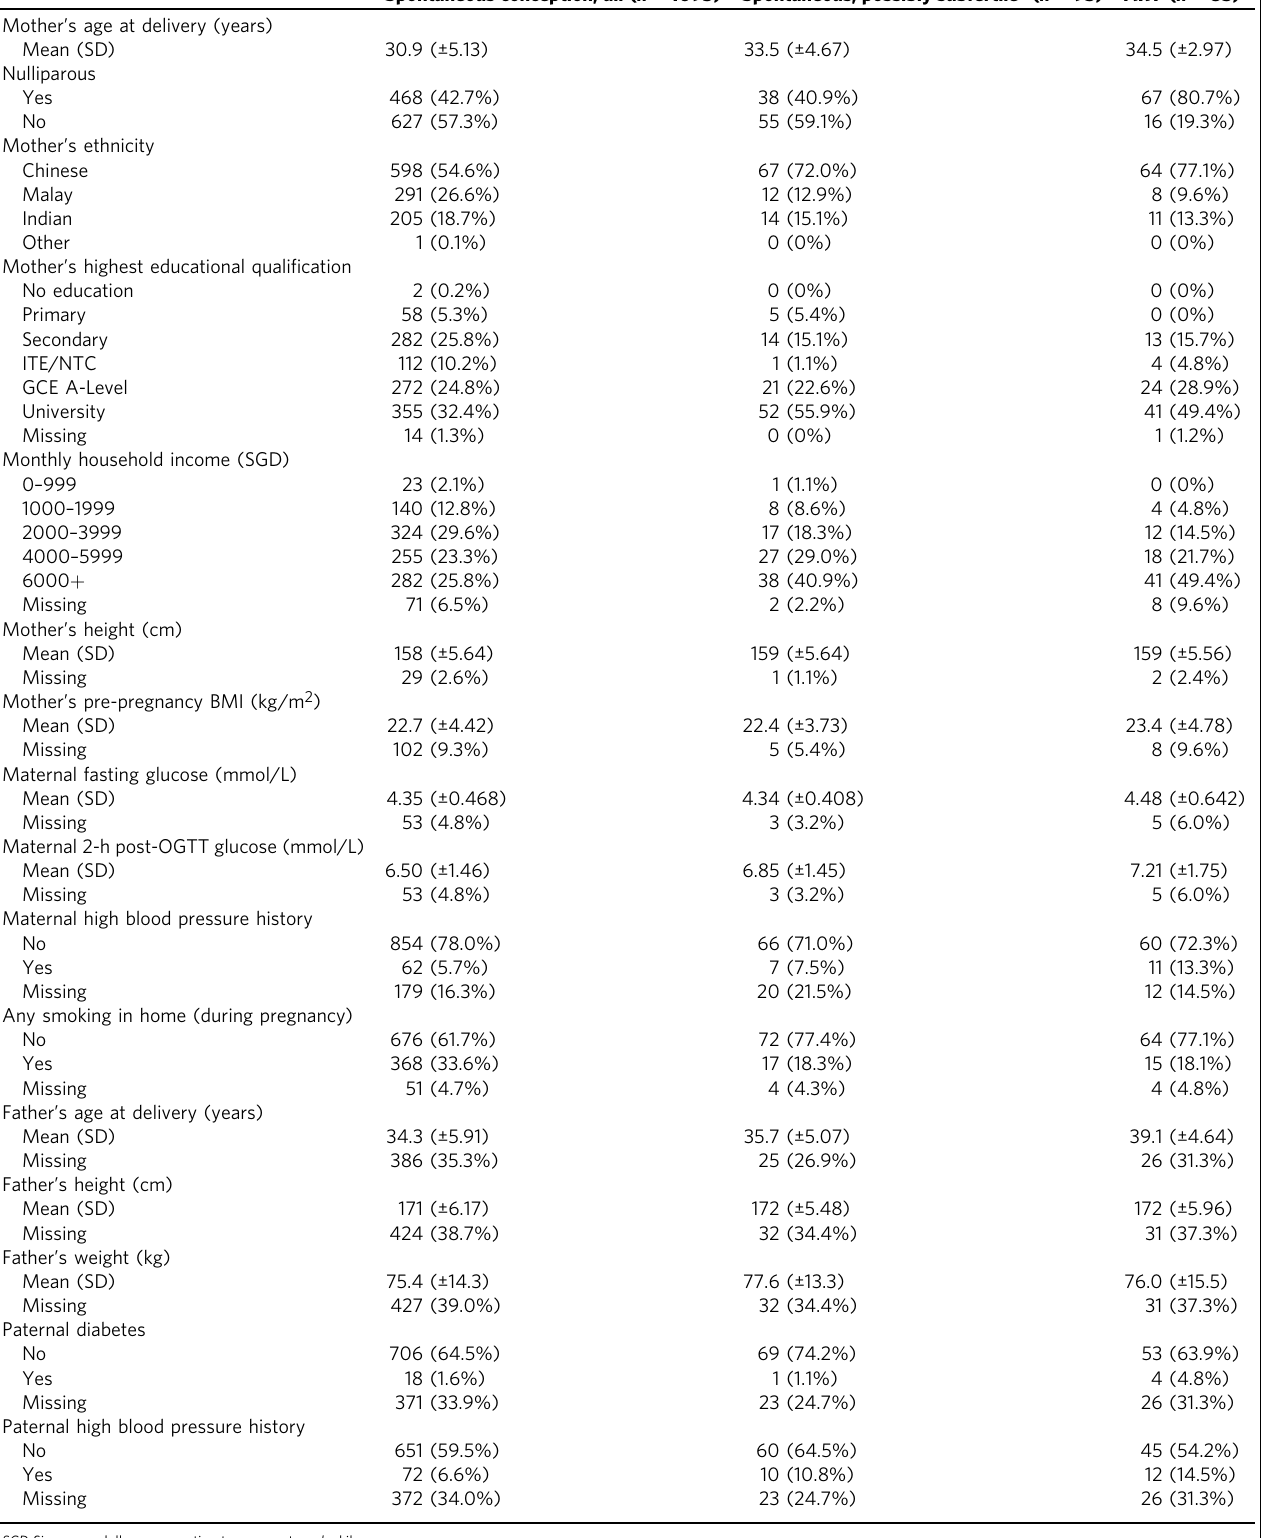
Table 1 Overall study population parental characteristics, by conception status a